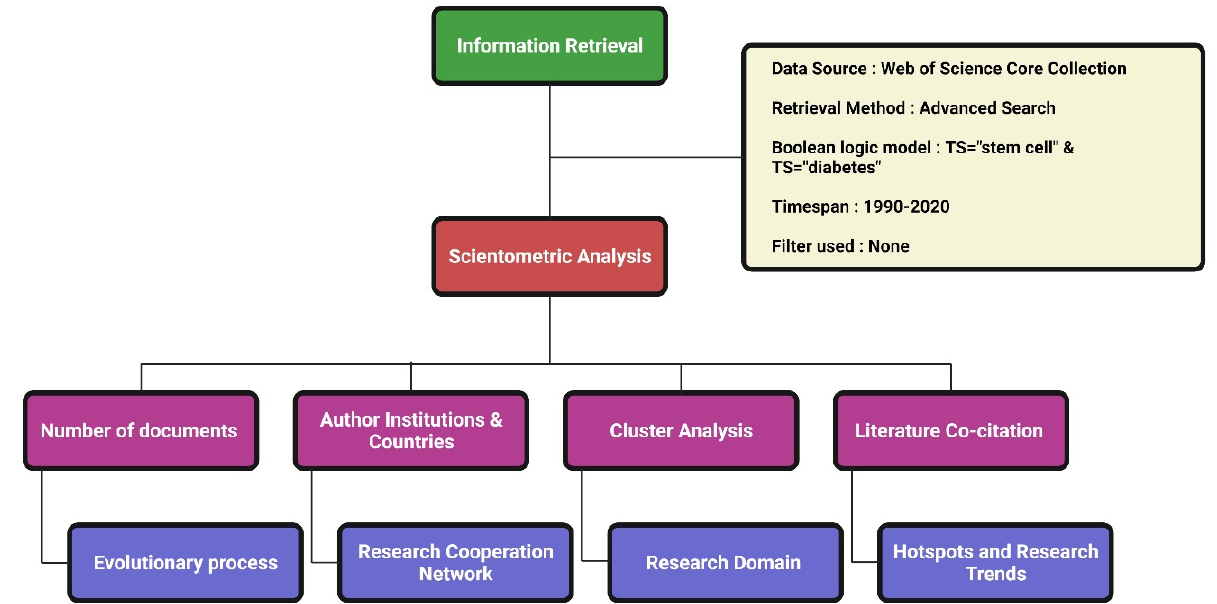
Figure 1. Scientometric analysis framework. Created with Biorender.com.